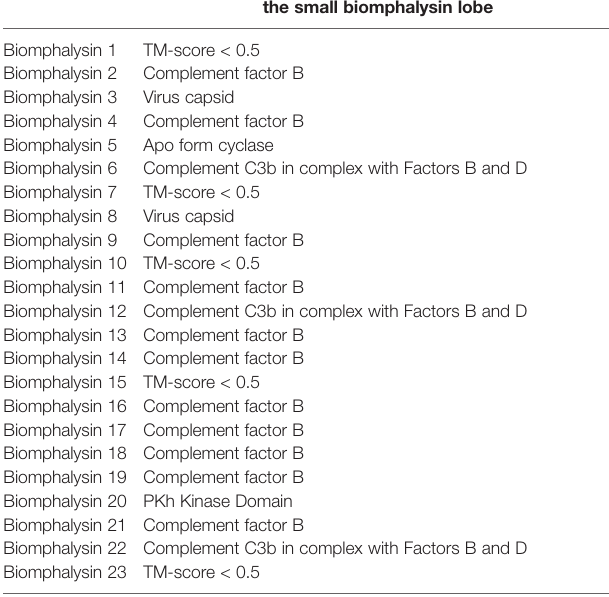
TABLE 1 | Best predicted hit for the structure of the small lobes of each biomphalysin. Top hit of I-TASSER structure predictiongenerated from the small biomphalysin